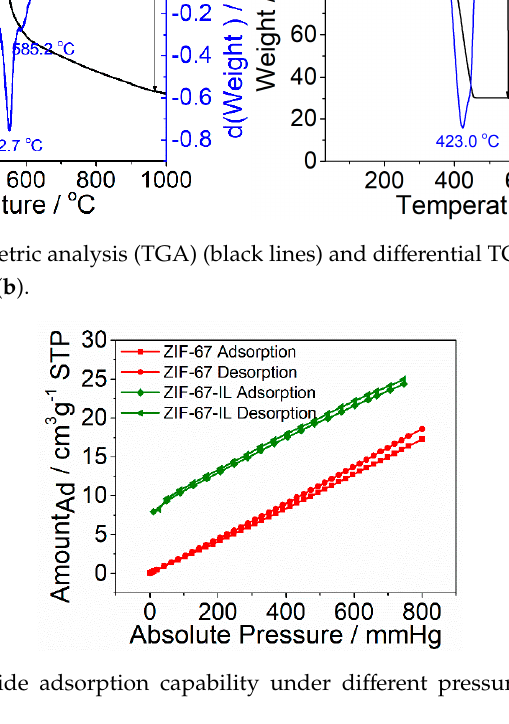
Figure 7. Carbon dioxide adsorption capability under different pressures at 25 °C for ZIF-67 and ZIF-67-IL.